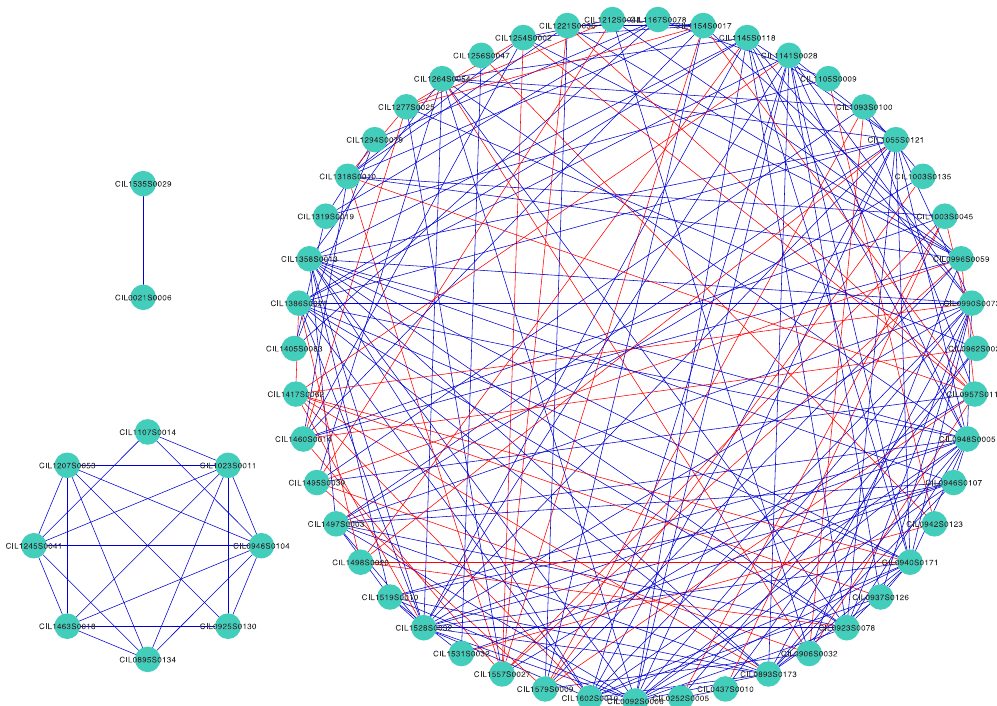
Figure 7. Co-expression networks of the 64 di ff erentially expressed R2R3-MYB genes in pecan after grafting. The blue line color represents positive correlations, and red represents negative correlations.